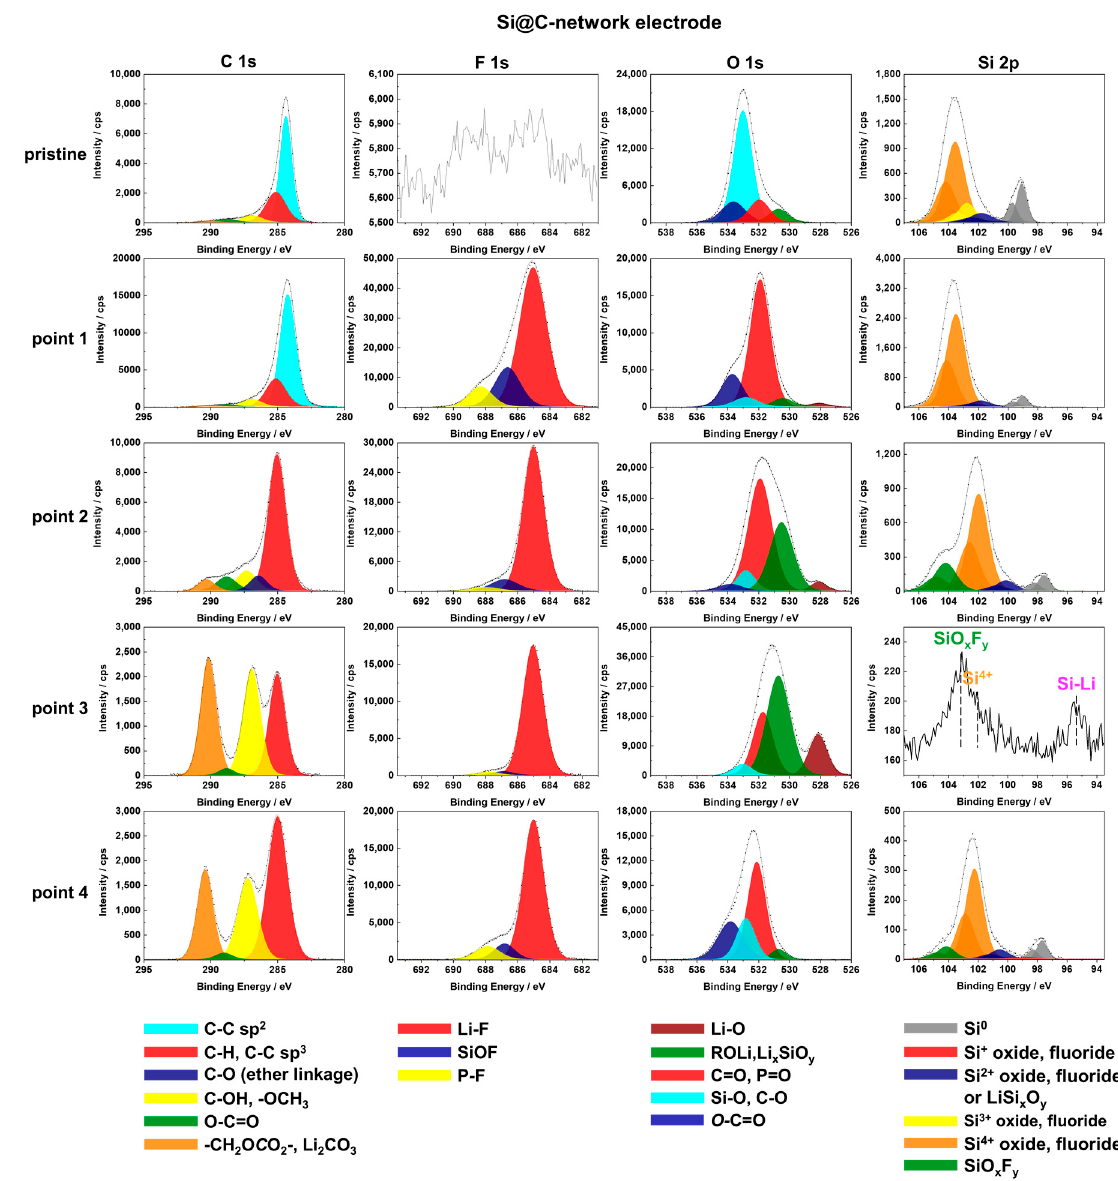
Figure 4. High − resolution C 1s, F 1s, O 1s, and Si 2p core level spectra obtained on the pristine and after different stages of lithiation/delithiation (points 1–4) in 1 M LiPF 6 /DMC of the Si@C − network electrode.